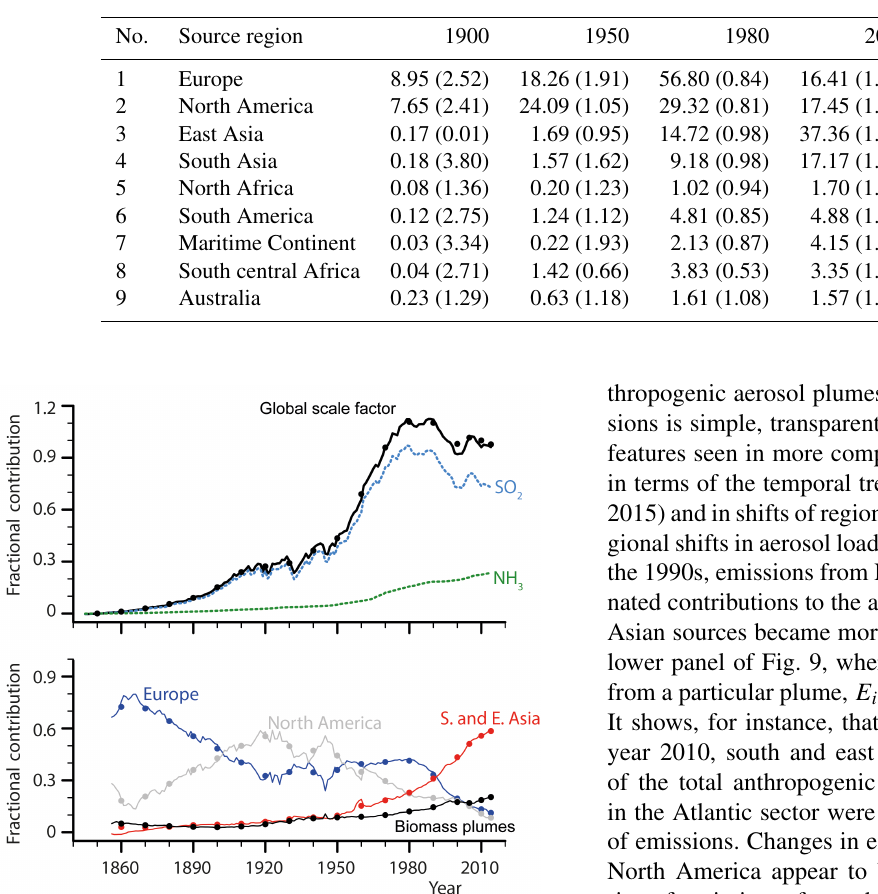
Table 6. Equivalent SO 2 emissions for the different plumes in different years in Tg SO 2 . The fraction of emissions of black carbon, relative to the fraction in 2005 is shown in parentheses. A value of 0.3 means that the black carbon fraction was 30% of the 2005 black carbon fraction in a given region.